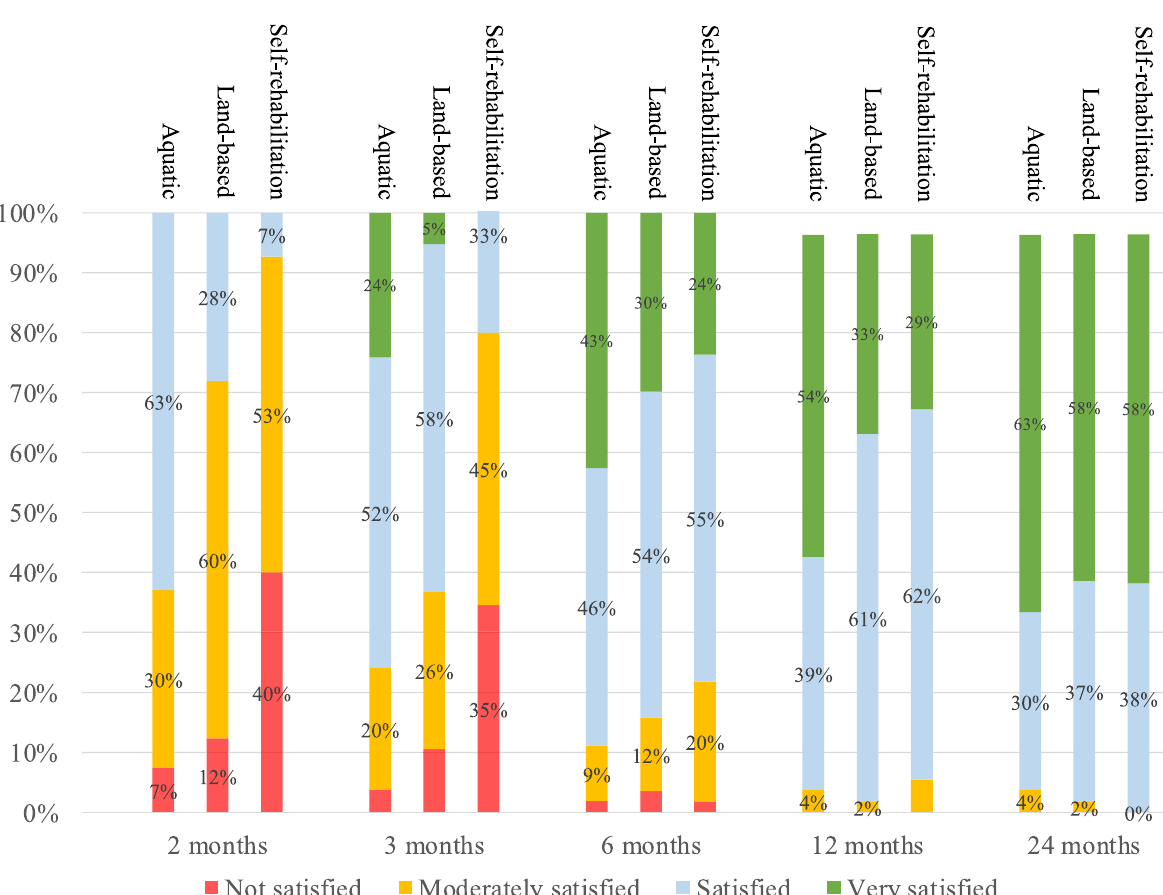
Fig. 4 Satisfaction for aquatic therapy, land-based therapy, and self-rehabilitation therapy for 24 months following rotator cuff